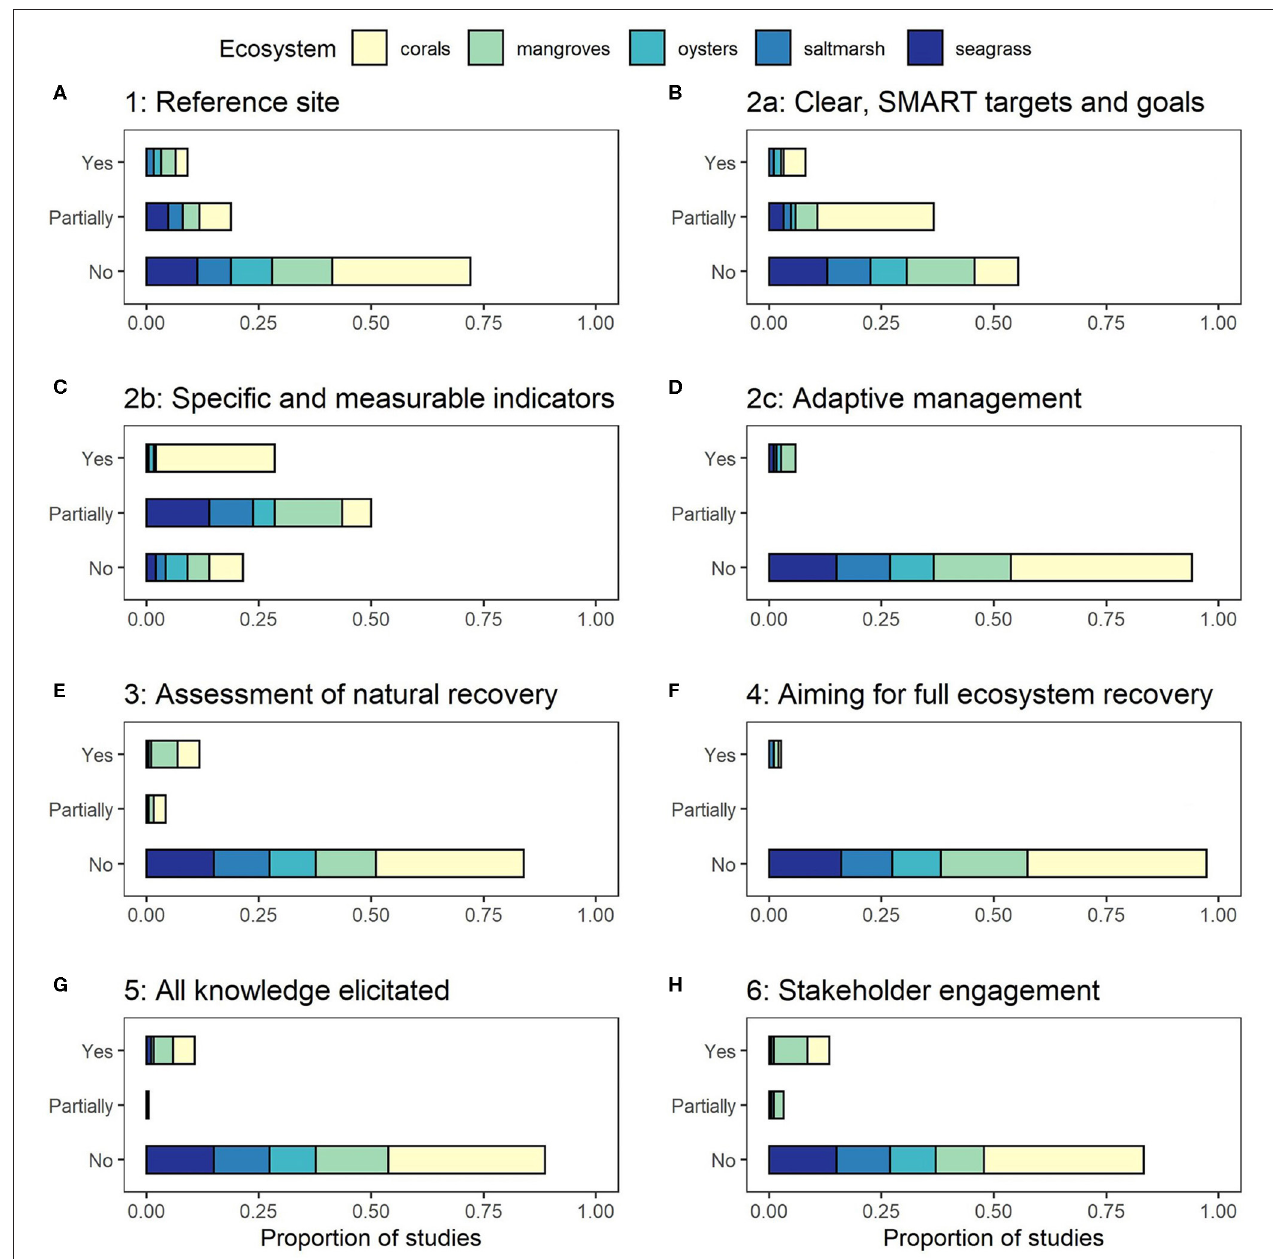
FIGURE 3 | Proportion of studies following the six standards for the practice of ecological restoration proposed by the Society for Ecological Restoration (SER) (McDonald et al., 2016). Studies were assessed based on the standard categories: (A) Reference site, (B) Clear, SMART targets and goals, (C) Specific and measurable indicators, (D) Adaptive management, (E) Assessing of natural recovery, (F) Aiming for full ecosystem recovery, (G) All knowledge elicited, and (H) Stakeholder